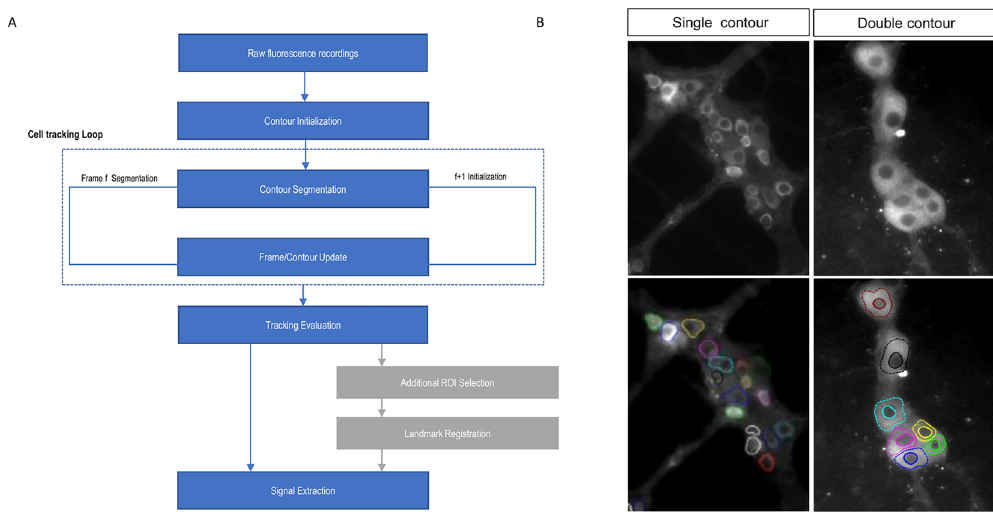
Figure 2. ( A ) diagram of the processing workflow including the main steps of cell tracking (Blue) and the optional ROI tracking (grey). ( B ) Example of the performance of the cell tracking procedure of multiple cells in ENS recordings, using one-layer tracking (left) and double contours